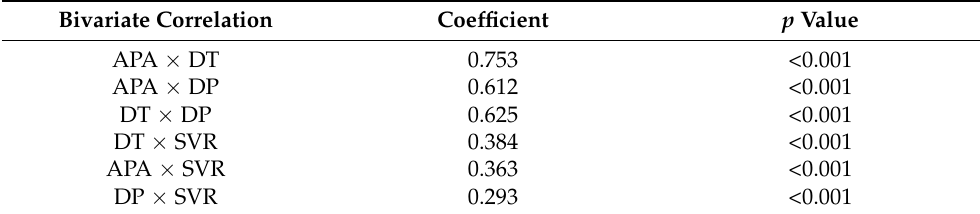
Table 5. Correlations between the subscales of Conduct Disorder Scores (%) in the Cross-sectional Life and Health Young Survey (LHS) study cohort ( n =